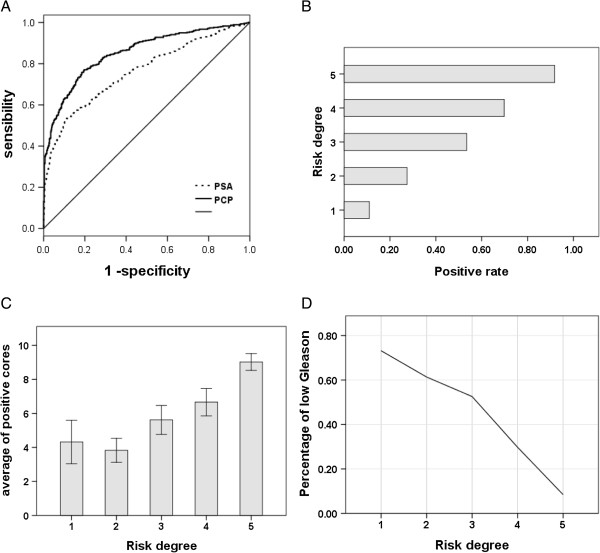
The ROC of our nomogram and predictive information in every risk degree. (A) The solid line represents the receiver-operating characteristic curve for the nomogram. (B) The strips represent the positive rate in patients at every risk level. (C) The strips represent the average number of positive cores taken from patients with positive results at every risk level. (D) The line represents the number of patients with positive results and a lower Gleason score (<7).